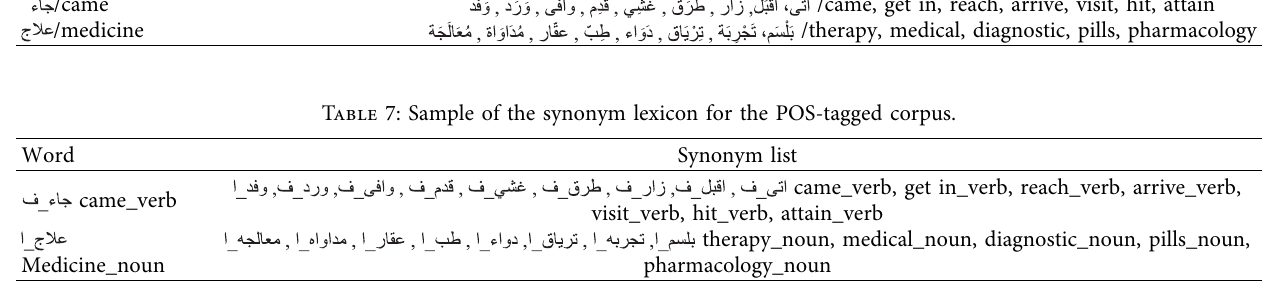
Table 8: The best-obtained results from KSUCCA corpus for p@(1–10), MAP, and MAR after fine tuning CBOW and SG